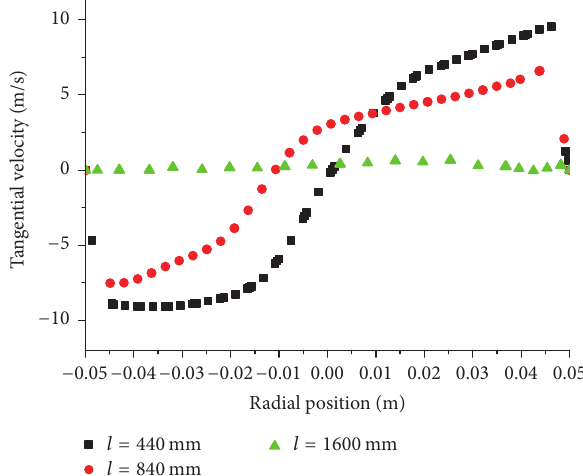
Figure 6: Tangential velocity distribution on the cross section of the separator middle